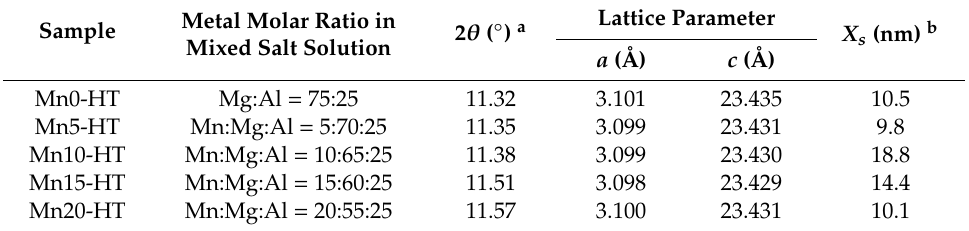
Figure 1. X-ray diffraction ( XRD) patterns of hydrotalcite precursors ( a ) and calcined samples ( b ). Figure 1. X-ray di ff raction (XRD) patterns of hydrotalcite precursors ( a ) and calcined samples ( b ). Table 1. Chemical compositions and lattice parameters of the synthesized Table 1. Chemical compositions and lattice parameters of the synthesized hydrotalcites.